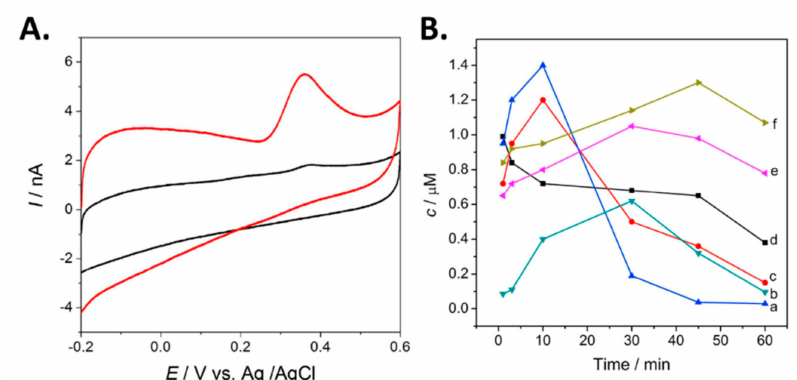
Figure 11. ( A ) CV voltammogram of 5 µ M serotonin at the bare microelectrode (black), and the GR- FeTSPc functionalized probe (red). ( B ) Concentration of DA obtained in vivo every 10 m with the following experimental conditions: (a) administration group given Uncaria rhyunchophylla, (c) the control administration group given antipsychotics, (d) the negative control group given saline and 5- HT at (b) the negative control group, (e) control administration group, and (f) administration group. Reprinted with permission [60].